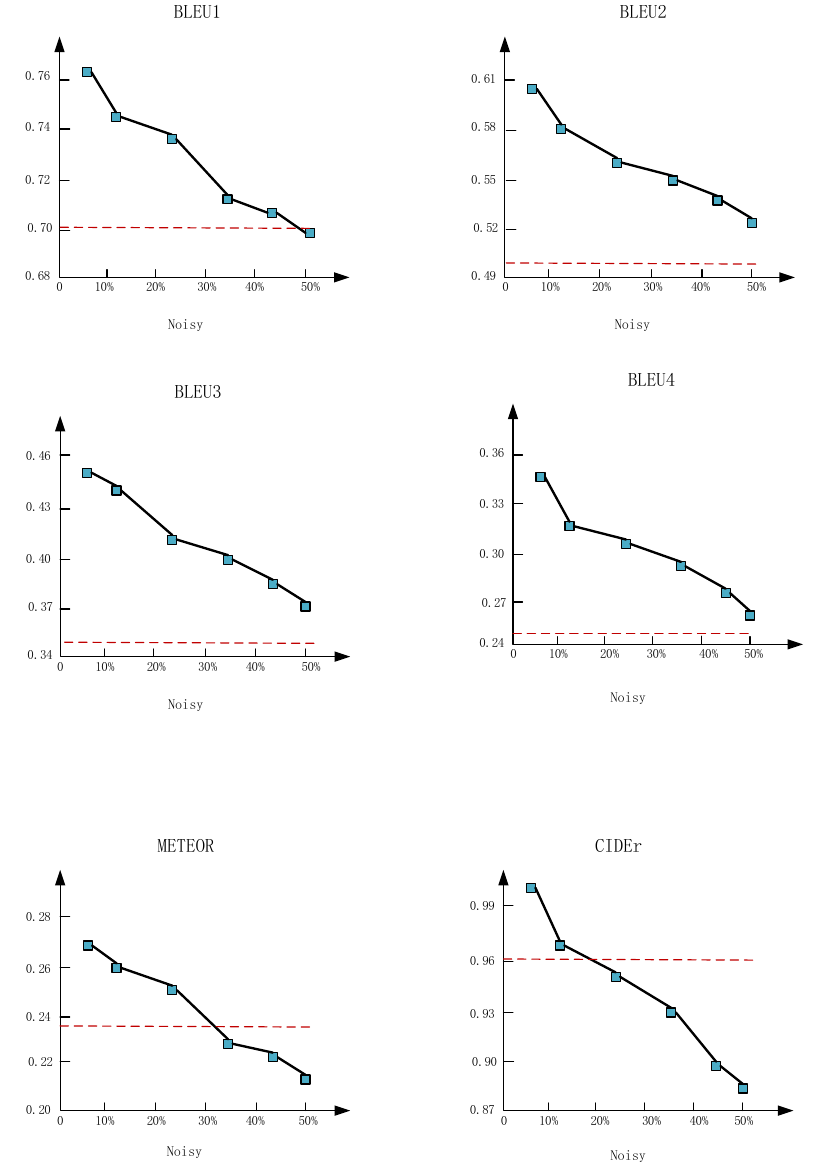
Figure 4. Variations of the performance with the increased noisy tags. The red dashes represent the results of the soft attention model